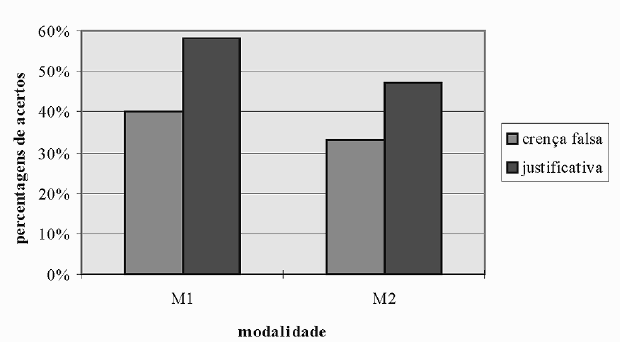
Figura 5. Percentagens de acertos das duas modalidades da tarefa de cren(cid:231)a falsa e de cren(cid:231)a falsa com justificativa. Nota . M1=modalidade1; M2=modalidade2